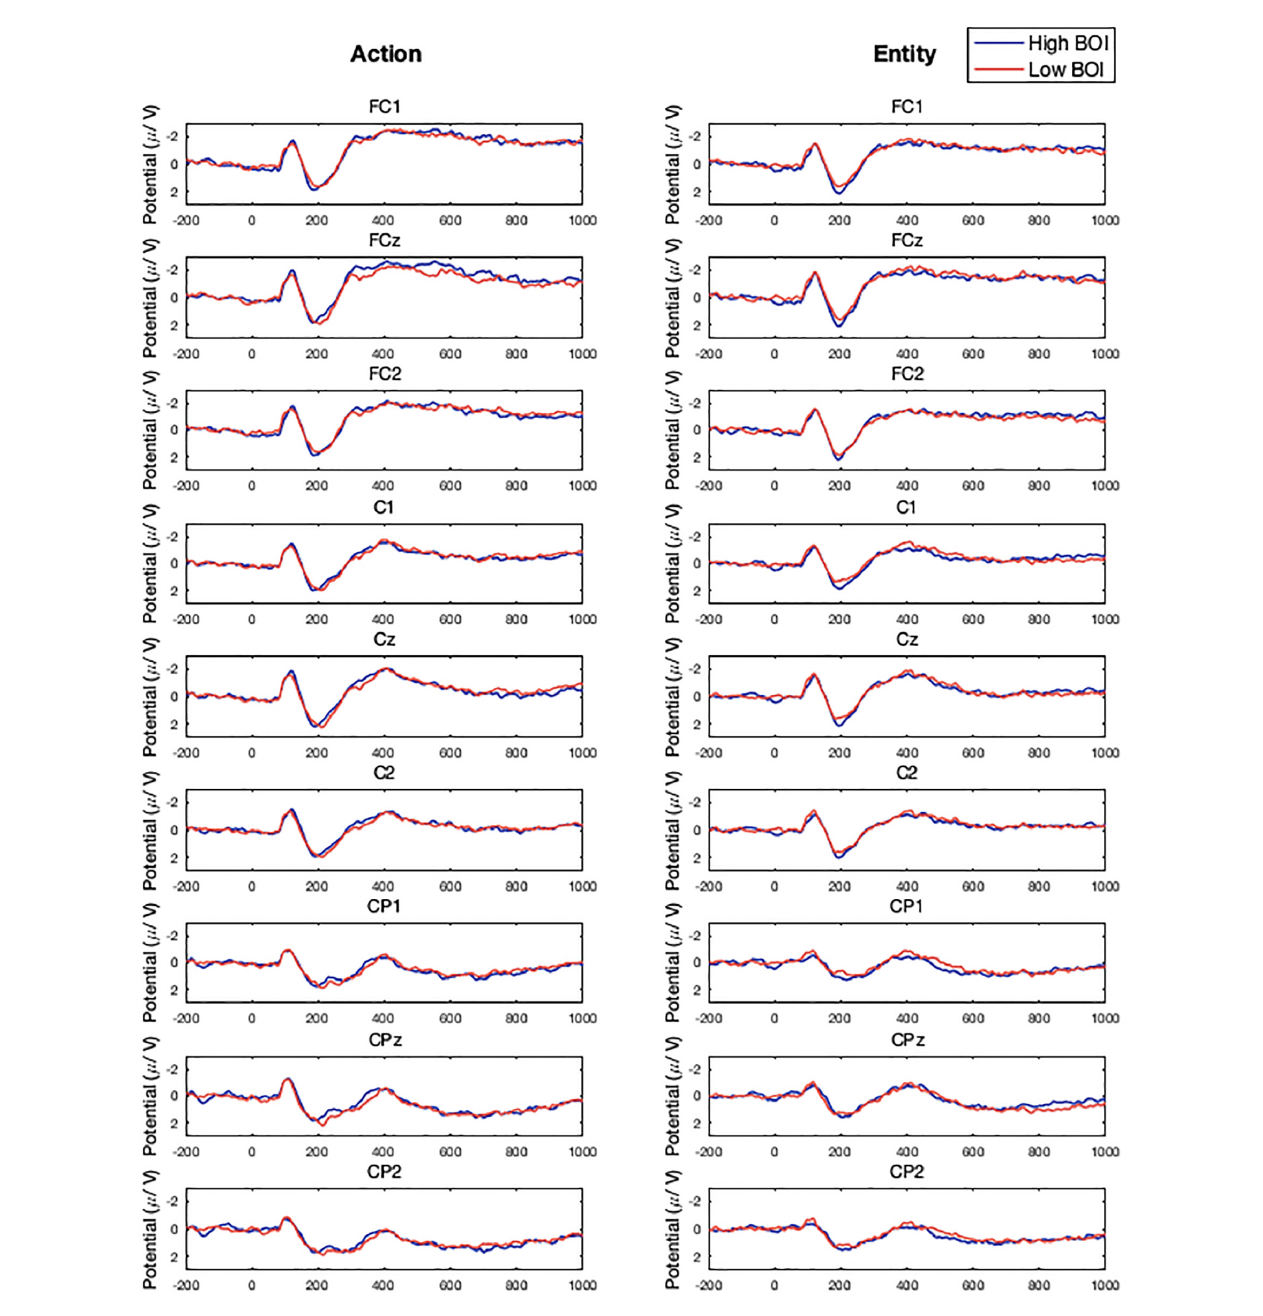
FIGURE2 Experiment 2 grand averaged, electrode-specific event related potentials (ERPs) by task condition and word type.